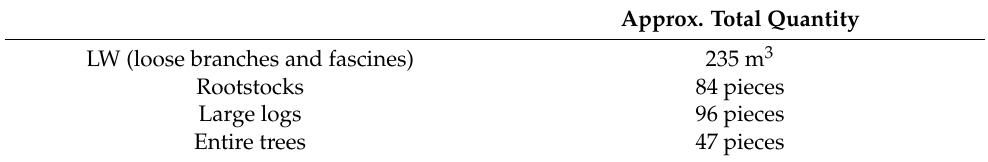
Table 3. Wood quantities used at the Witibach stream (Grenchen SO).